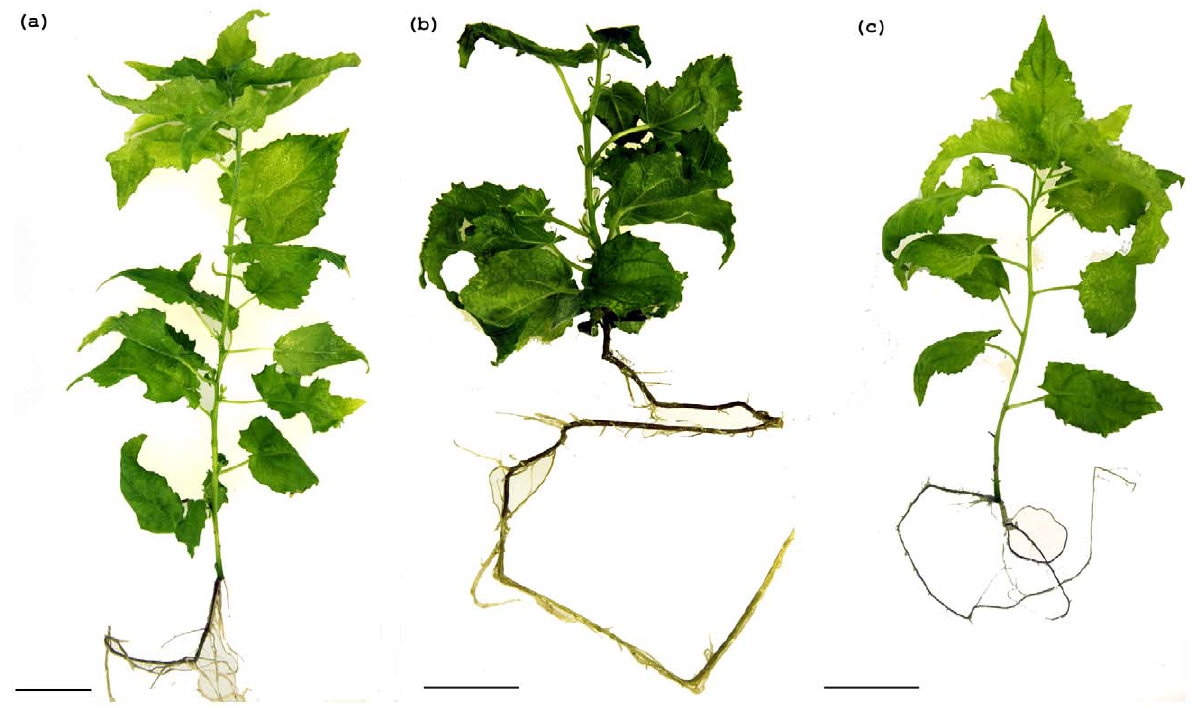
Figure 5. Phenotypes of PCN35S::PCN-miRNAd gain of function and 35S::miRNA-PCN knockdown plants compared to wild-type controls. (a) Wild-type plants (2 months old). (b) PCN 35S::PCN-miRNAd gain of function (2 months old) plants have changes to plant architecture, shorter plants length, darker green color in leaf. (c) 35S::miRNA-PCN knockdown plants (2 month old) have no strong differences from the wild-type. Bar=2.5cm.